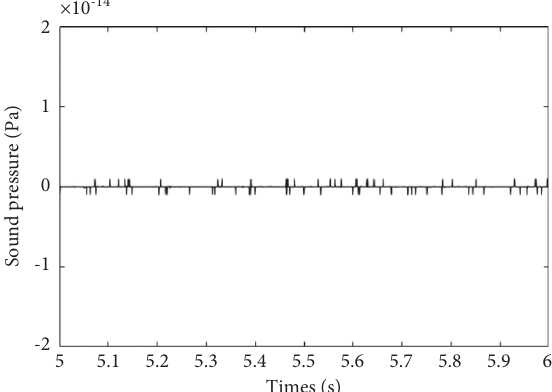
Figure 21: CEEMDAN reconstruction signal